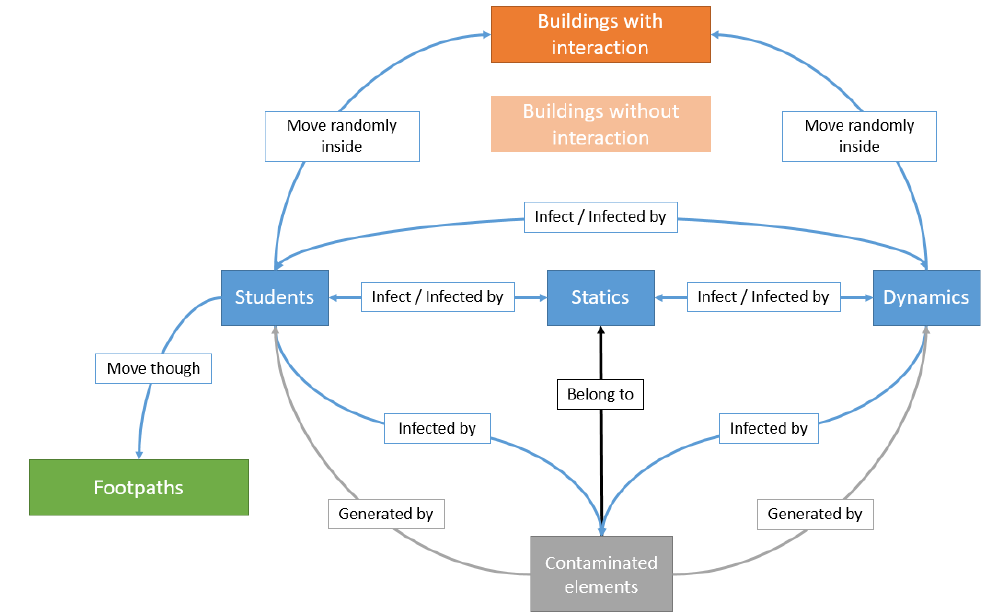
Figure 7. Spatial and temporal relationships of ABM agents during simulations. Blue boxes relate to the agents that can transmit the disease and be infected by someone else; a grey box relates to the contaminated elements and is linked to the agents that can produce them and be infected by them; a green box represents the footpath and is linked to the agents that can use them; while orange boxes represent the buildings with and without interactions and are linked with the agents that move inside them.